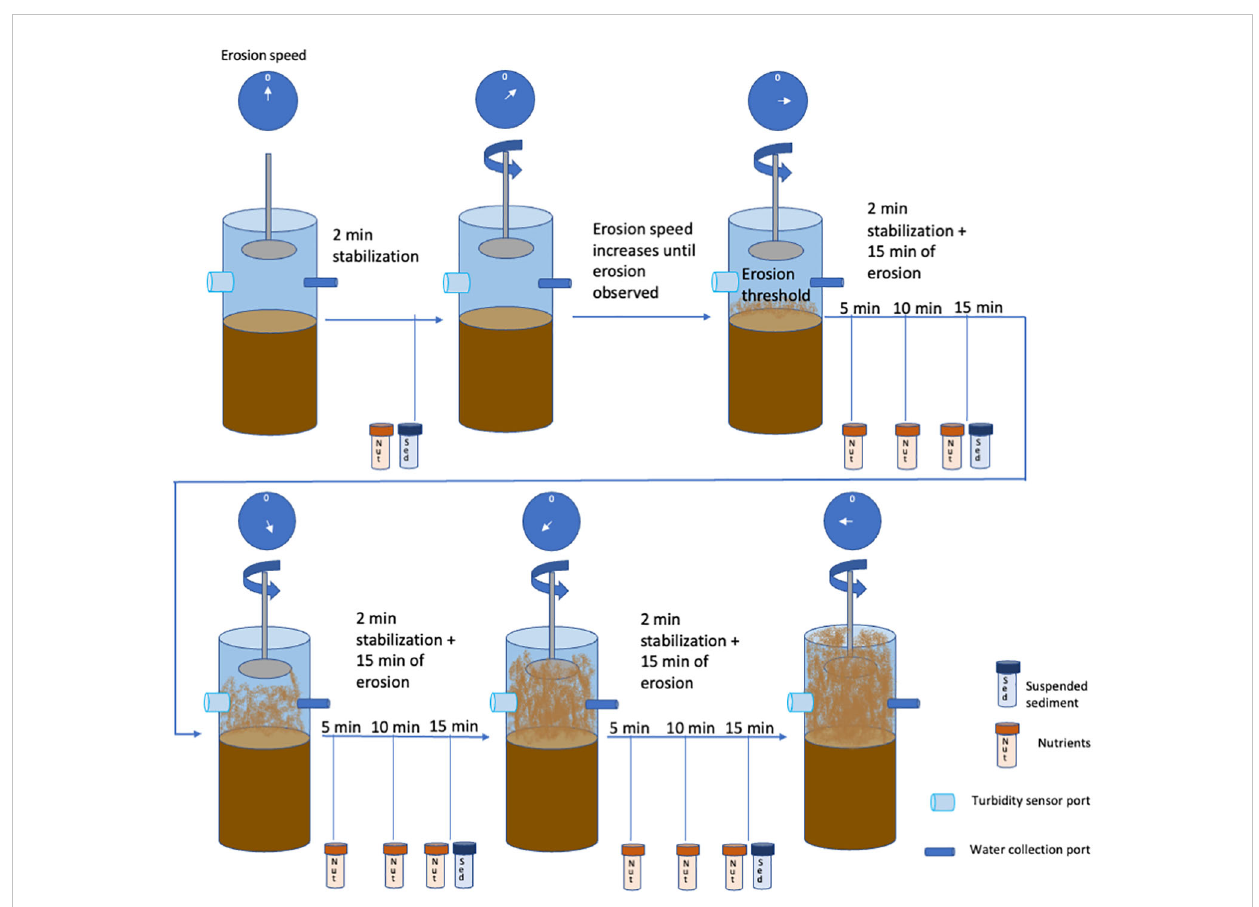
FIGURE 2 Scheme of nutrient and suspended sediment sampling procedure during the erosion experiment. Orange vials correspond with nutrient samples and blue vials to suspended sediment samples. Circles at the top represent increasing speed of the